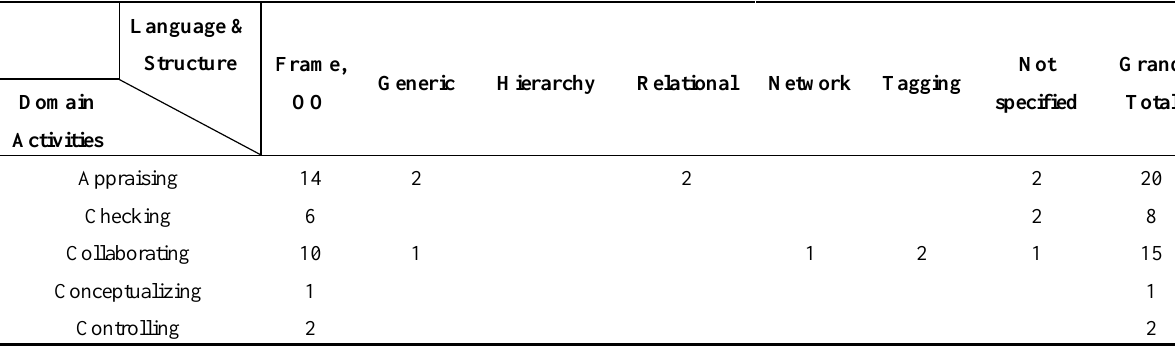
Table 3. Classification Structures to Domain